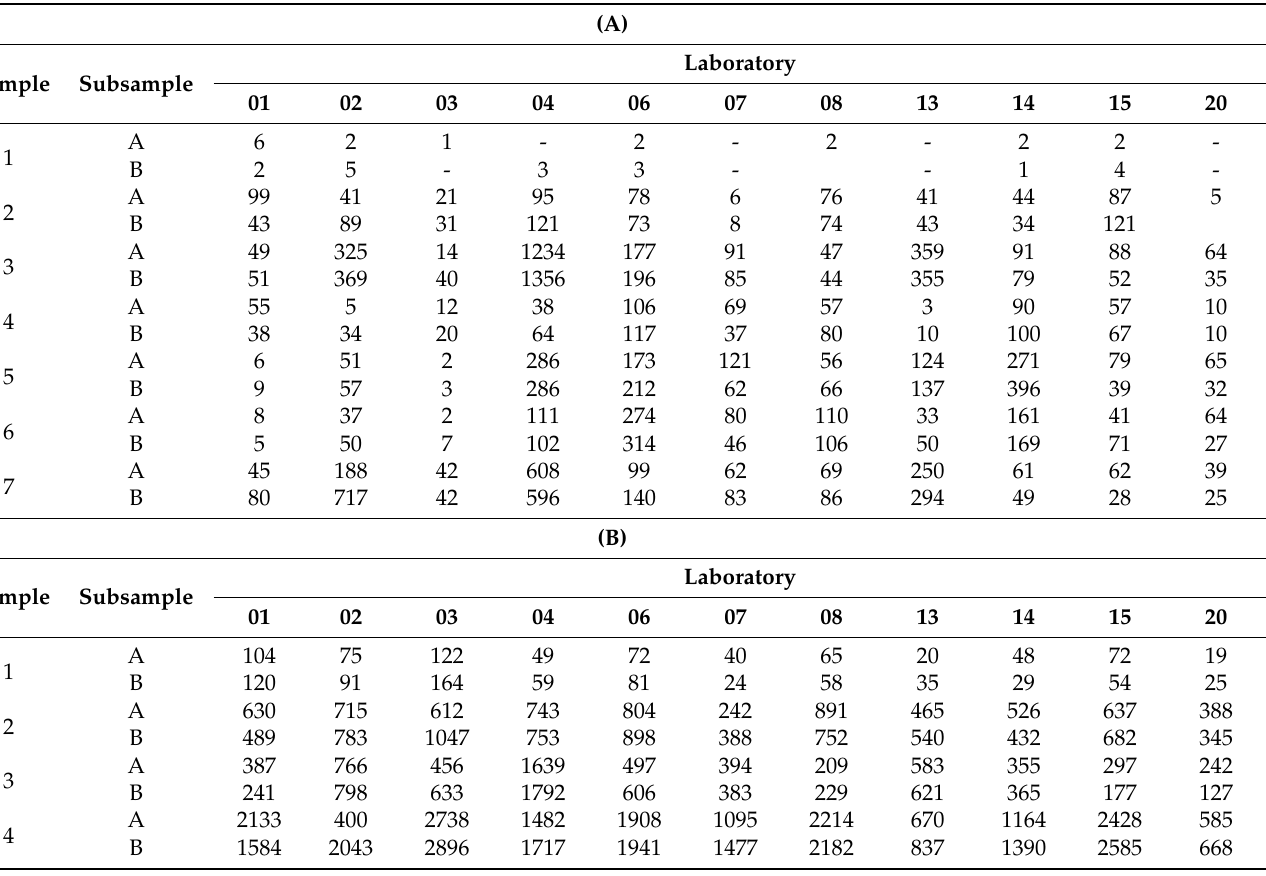
Table 6. False positive reads obtained for samples 01–07. ( A ): AGES database, ( B ): NCBI database. Laboratories 01–06, 08, 14, 15: MiSeq; laboratories 07, 13, 20: iSeq